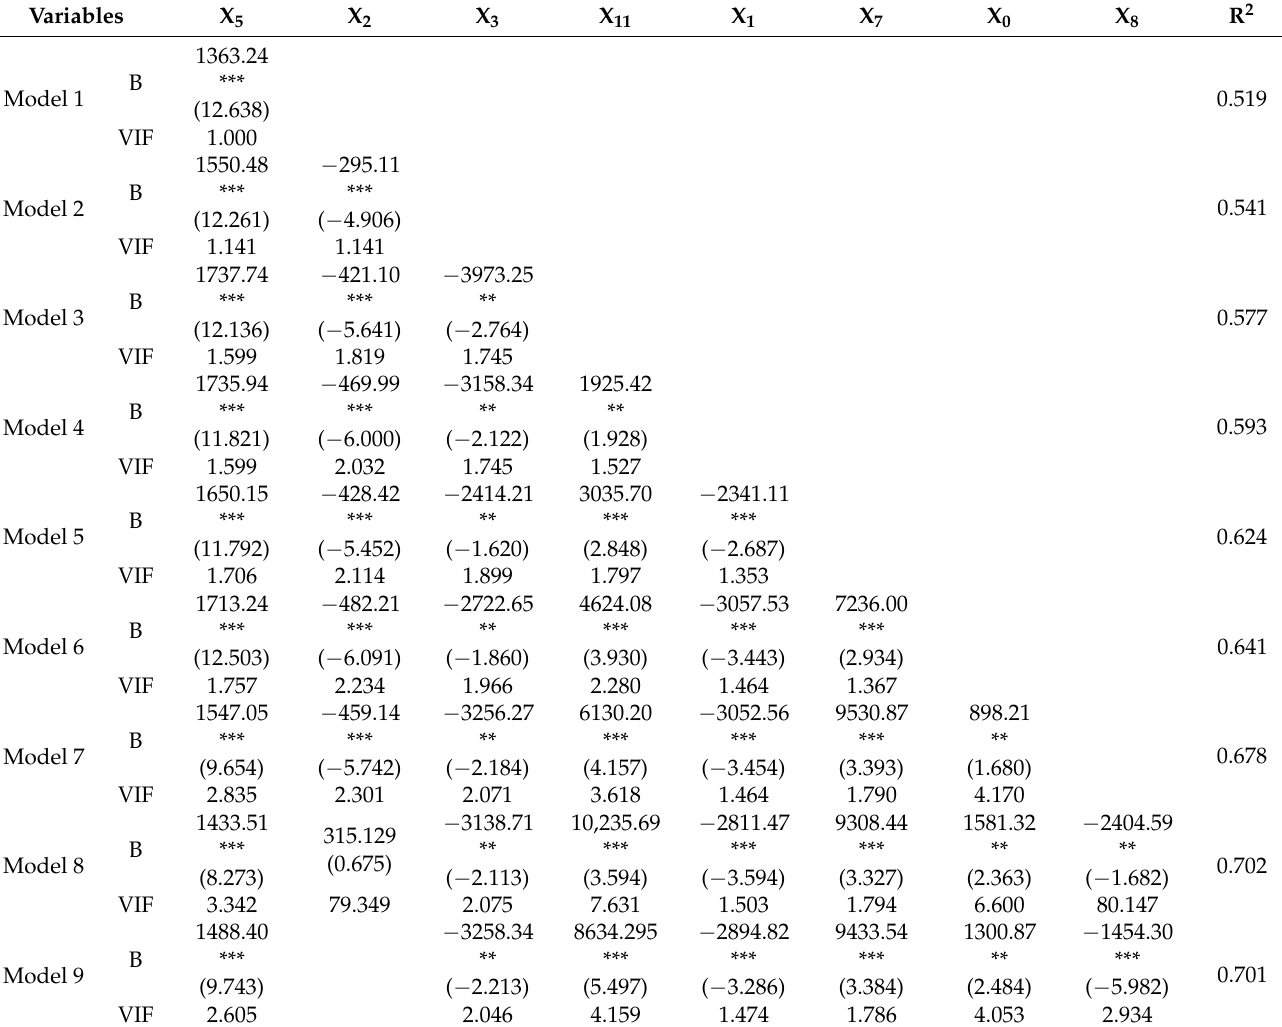
Table 4. Results of the price model of office